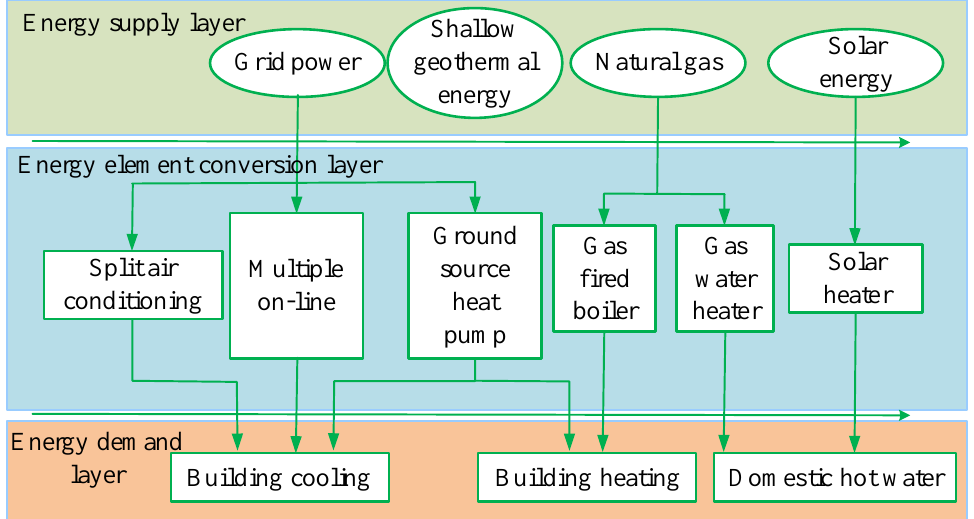
Figure 2. Schematic diagram of energy circulation of regional building energy system.